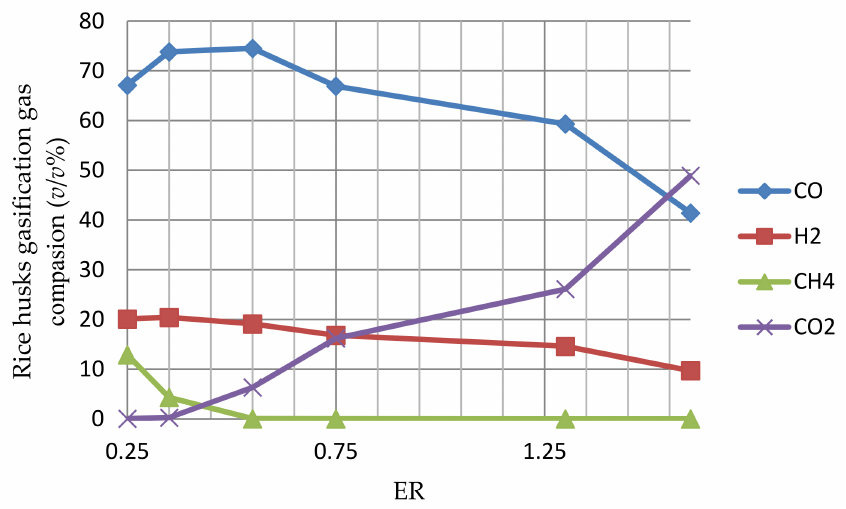
Figure 3. Effect of ER on the composition of the syngas simulated by Aspen